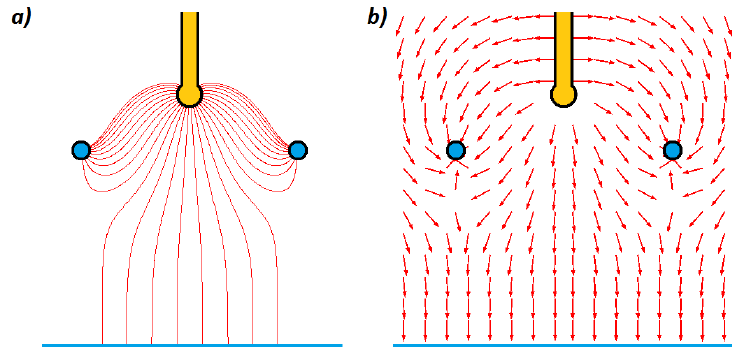
Figure 4. Sketch of electric field lines associated with the droplet ( a ) and direction of the electric field ( b ) for the induction method. A target and a nozzle with a droplet are grounded and the polarity of the voltage applied to the ring electrode is negative, so the induced charge is positive.